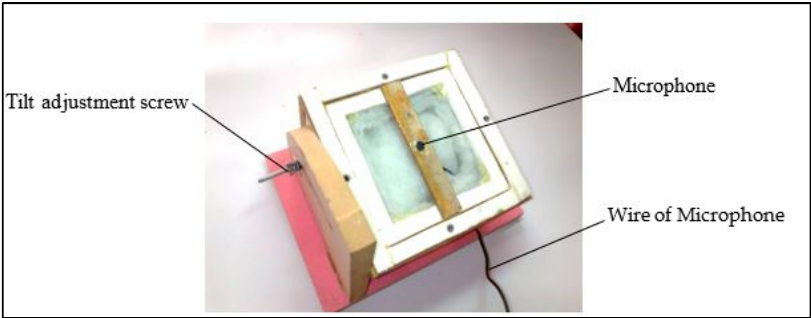
Figure 4. Acoustic chamber.